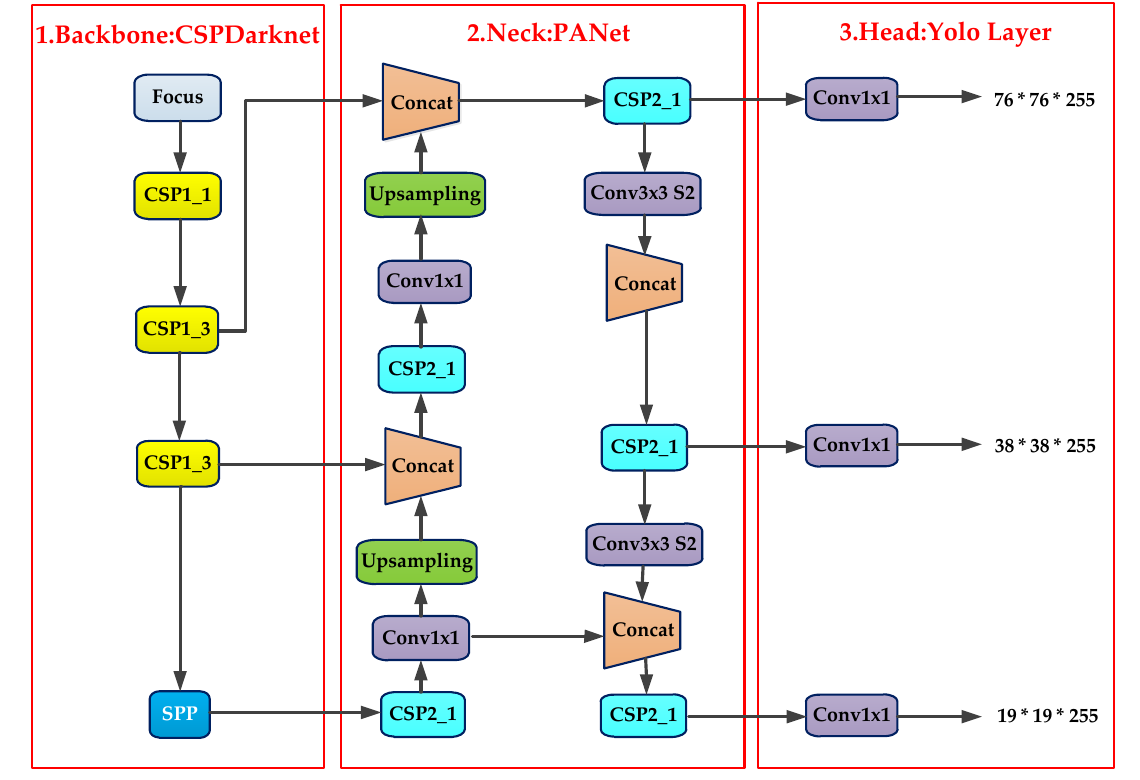
Figure 3. The network architecture of YOLOv5. (1) Backbone: CSPDarknet for feature extraction; (2) Neck: PANet for feature fusion; (3) Head: YOLO layer for prediction.